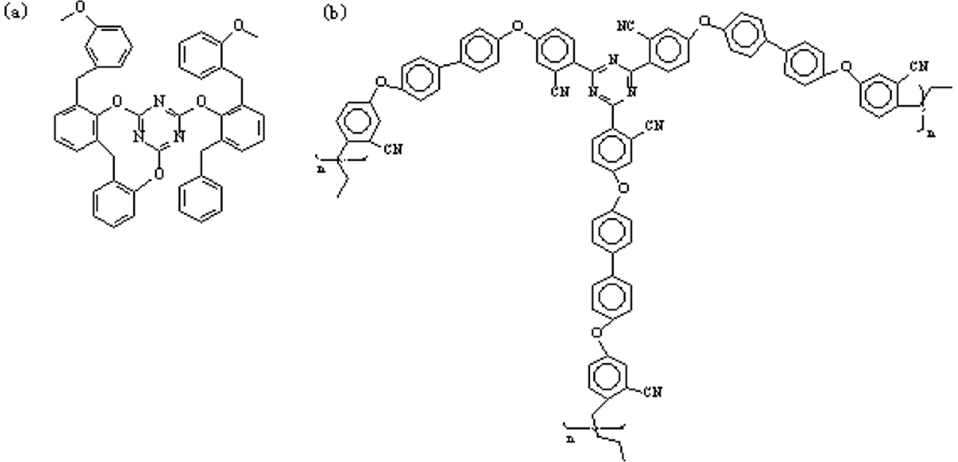
Figure 7. The possible structure of the blends: ( a ) Structure of cured NCE; ( b ) Structure of cured phthalonitrile.